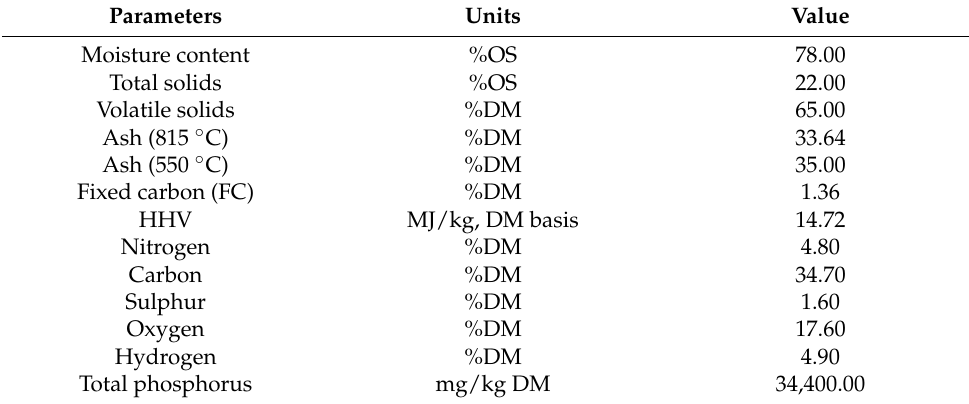
Table 2. Proximate and ultimate analysis of sewage